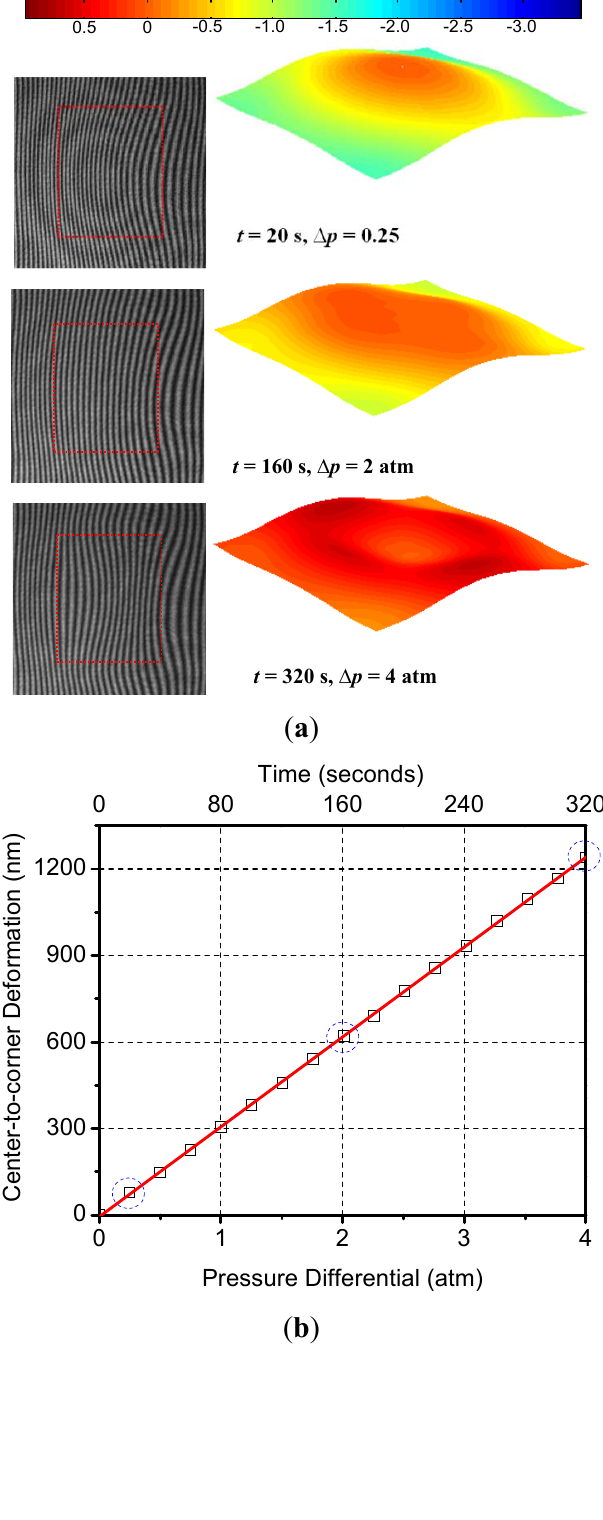
Figure 11. ( a ) Representative fringe patterns and 3-D deformation maps obtained during the calibration process (the units in the scale are μ m and the cavity location is indicated by the dotted box); ( b ) calibration curve (the encircled values correspond to the fringes in